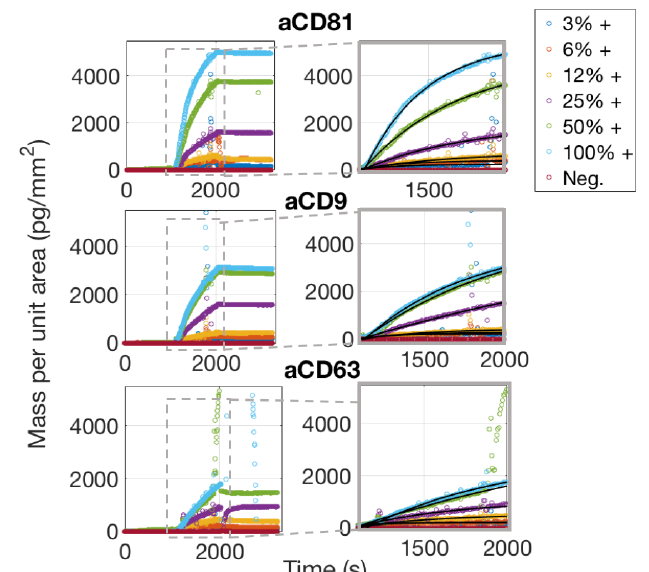
Figure 6. Simultaneously acquired real-time binding curves of EVs accumulating onto three different probes, each at six different concentrations. The insets focus on the association phase of the curves, which was fitted with a multivalent model that separates an initial, fast association rate k on , fast from a slower, subsequent rate k on , slow as explained in the Discussion section